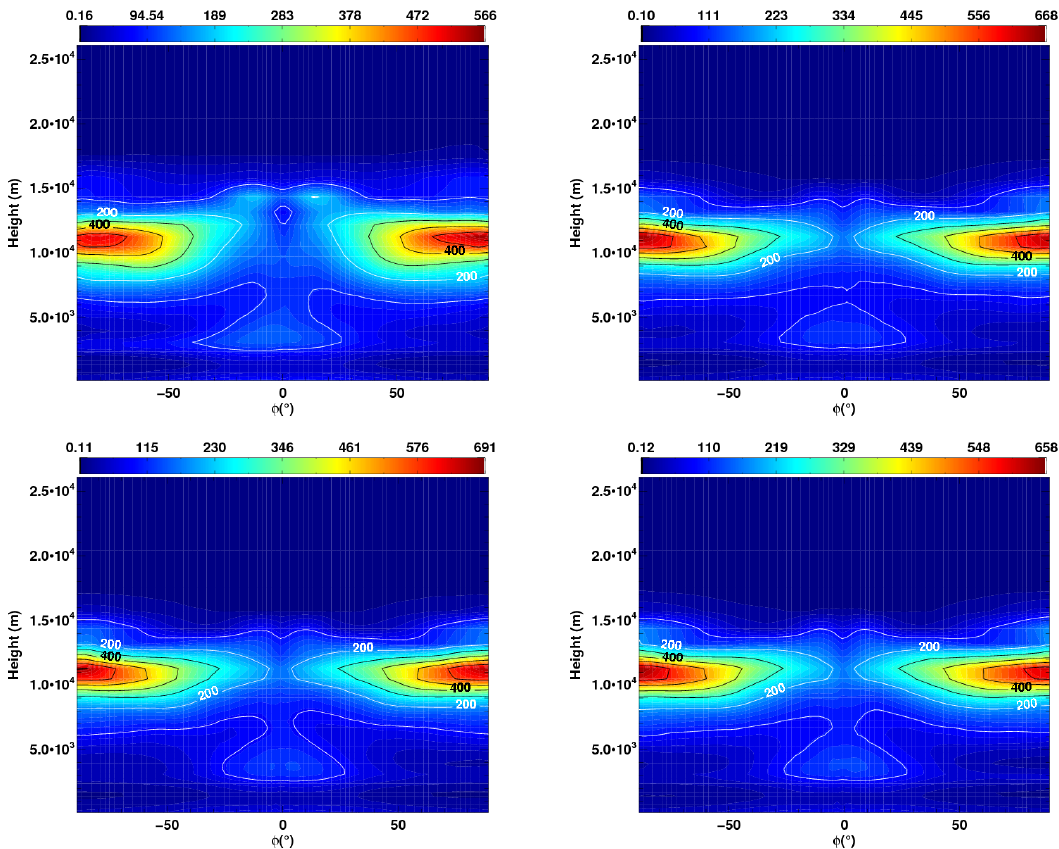
Figure 22. Figure, for the tidally locked Earth test (Merlis and Schneider, 2010; Heng et al., 2011b), showing the zonally (in geometric height) and temporally averaged EKE (see Sect. 3.1) as a function of latitude and height. Top left panel ND, top right panel EG sh , bottom left panel EG gc and bottom right panel EG models (see Table 2 for explanation of model types). Note the contours (solid lines) are the same in all plots.